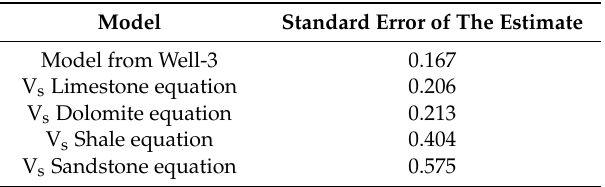
Figure 1. Shear velocity vs. compressional velocity for Well-2 (blue dots) along with the empirical equations (Castagna) and linear model from Well-3. Note the misfit of the empirical equations. Table 1. Standard error of the estimate for different models.